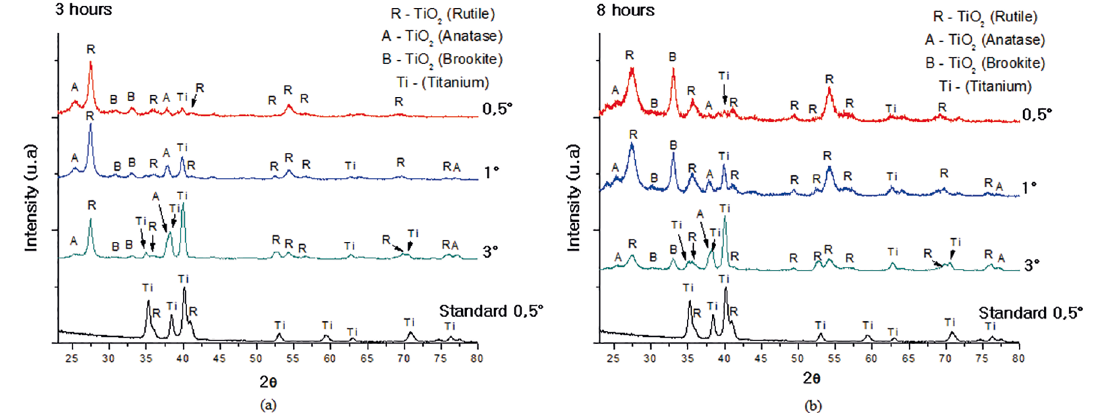
Figure 2. Diffractograms of the X-ray samples in GIXRD of the titanium samples. (a) treatment in 3, (b) treatment in 8